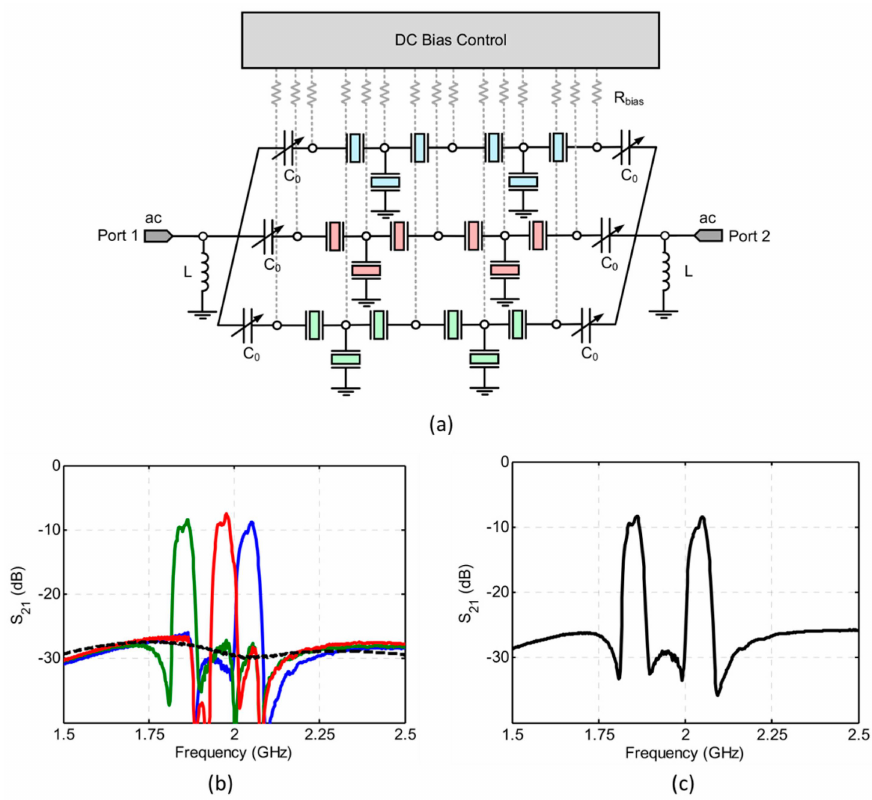
Figure 16. ( a ) Structure of the 2.5-stage BST switchable FBAR filter [116]. ( b ) Electrical response of the measured 2.5-stage switchable filter and the OFF-state response of the filter is provided in a dash line [116]. ( c ) Electric response of the filter when two switches are opened simultaneously [116]. Reproduced with permission from